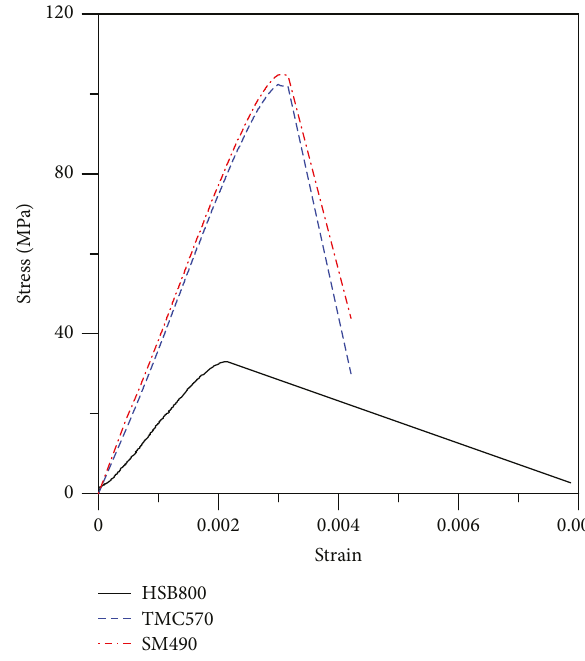
Figure 3: Stress-strain relation of